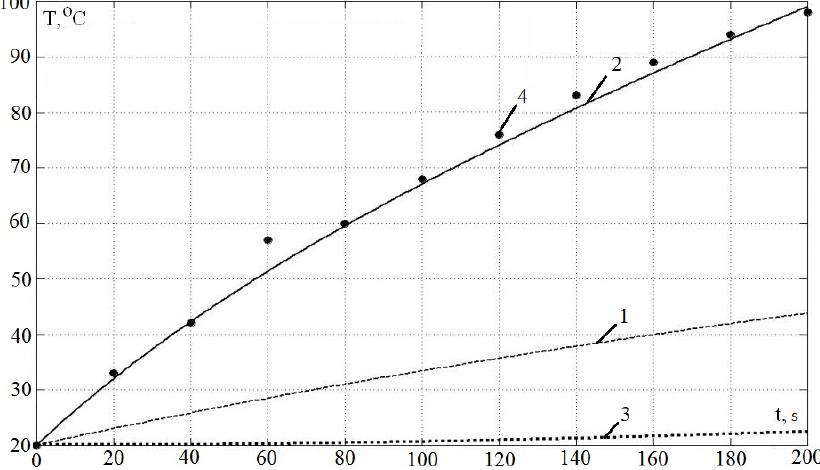
Figure 5. Comparison of calculation results and experiment. 1—primary winding average temperature (calculated); 2—secondary conductive plate average temperature (calculated); 3—primary core average temperature (calculated); 4—secondary conductive plate average temperature (experiment).